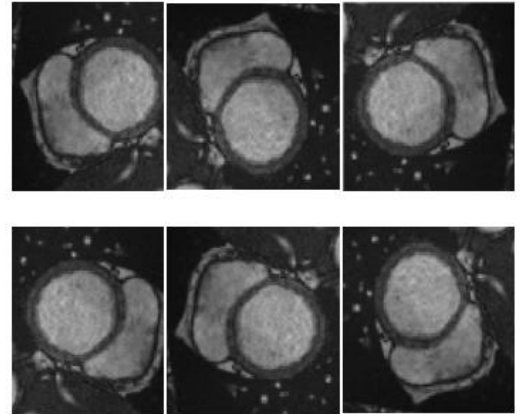
Figure 4. Schematic diagram of data enhancement.